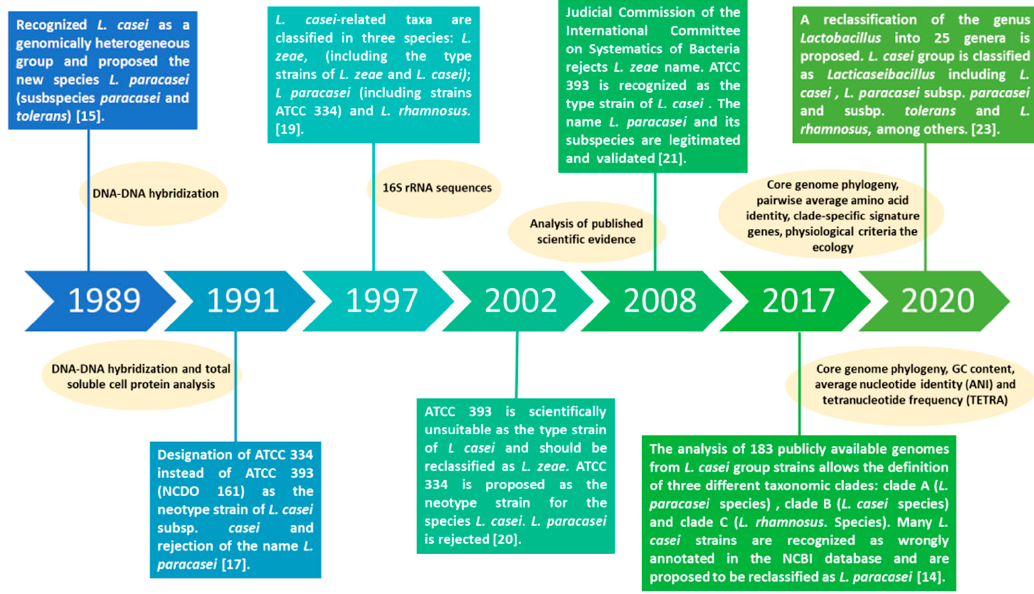
Figure 1. Timeline of the main events on evolution of classification and taxonomy of Lacticaseibacillus along with the methodology applied in each report. ATCC: American Type Culture Collection; NCDO. National Collection of Food Bacteria